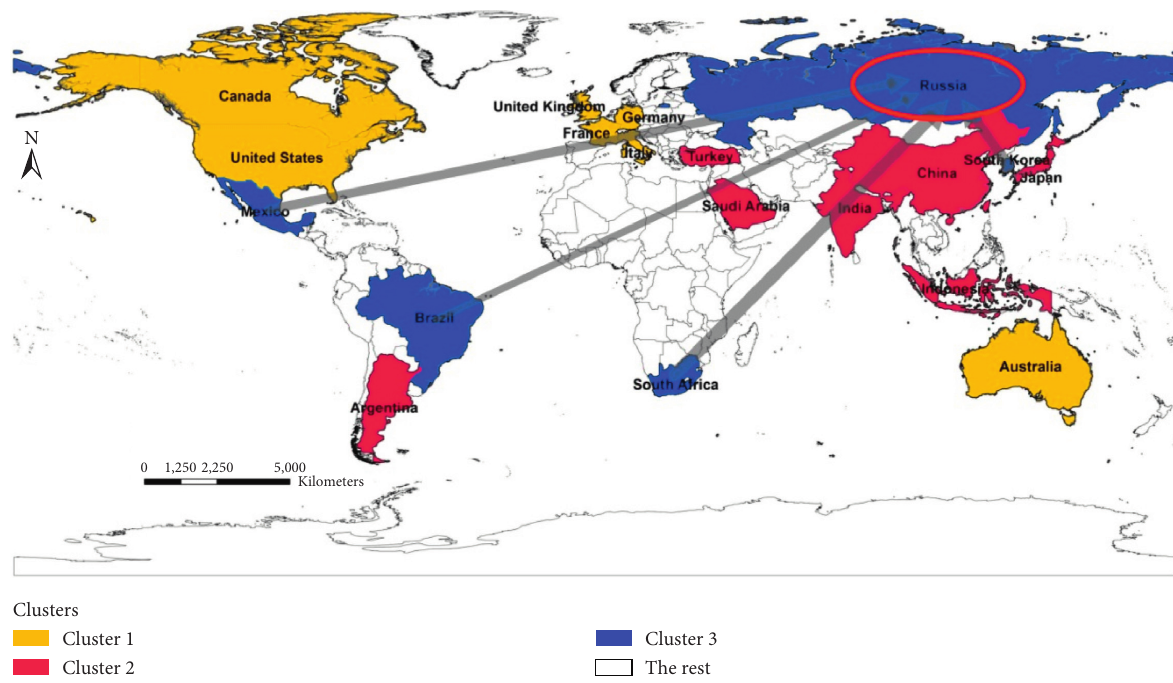
Figure 11: The volatility spillovers from Bovespa (Brazil), IPC (Mexico), INVSAF 40 (South Africa), and KOSPI (South Korea) to RTS